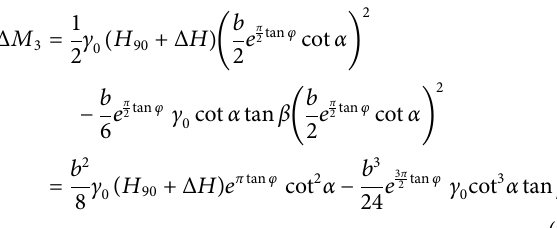
FIGURE 4 | Slip mode diagram when ( H 90 + Δ H )/tan β > AI